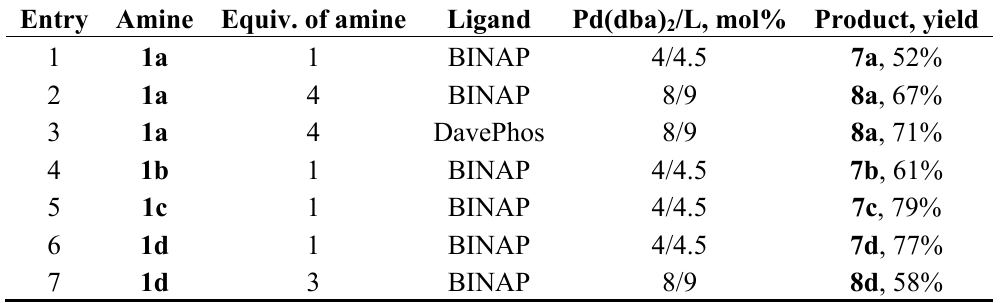
Table 3. Pd-catalyzed amination of